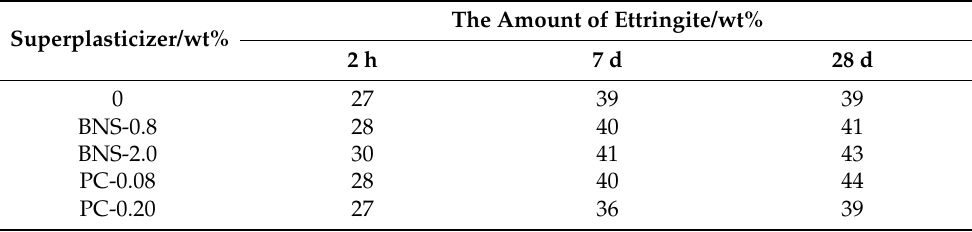
Table 7. The amount of ettringite in C 4 A 3 S pastes hydrated with different dosages of superplasticizer.